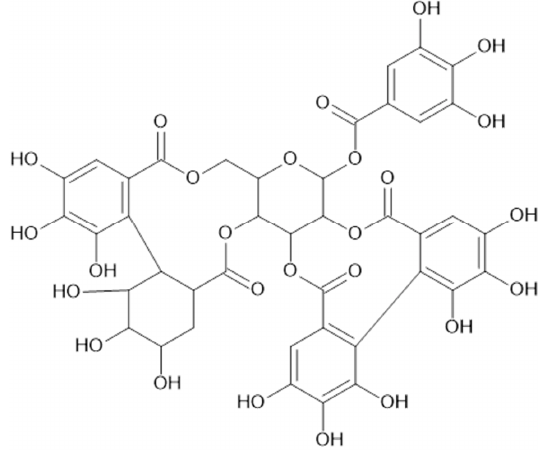
Figure 13. Chemical structure of compound 66 (MW = 936).